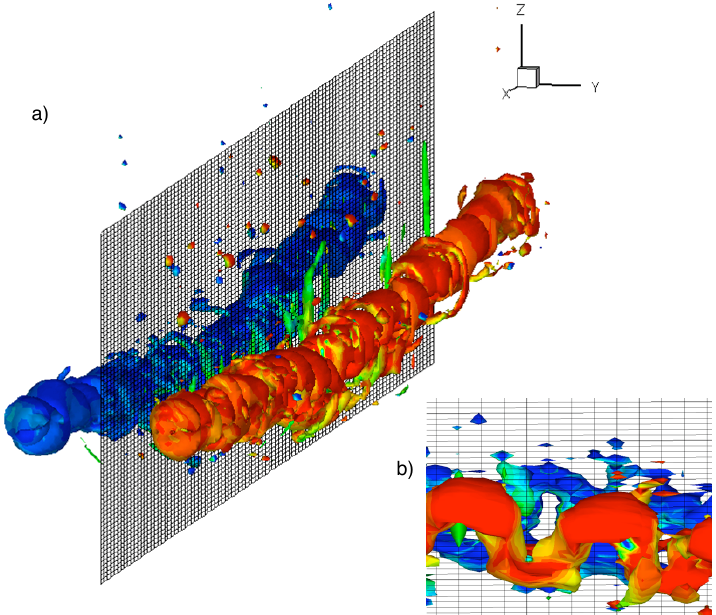
Fig. 5. Three-dimensional structure of the wake at t = 120s (run V 1) represented by the isosurafce of the vorticity invariant λ 2 =− 0 . 7 (Jeong and Hussain, 1995) colored with the isosurface of axial vorticity ω x (the red, blue and green colors identify the levels ω x = 0 . 1s − 1 , -0 . 1s − 1 and 0, respectively). Panel (a) on the left shows the emergency of Crow or long-wave ( LW ) instability ( λ LW ∼ 400m = L x ). Panel (b) on the right is a zoom from panel (a) , showing the emergency of elliptical or short-wave ( SW ) instability ( λ LW ∼ 20m = 4 1x